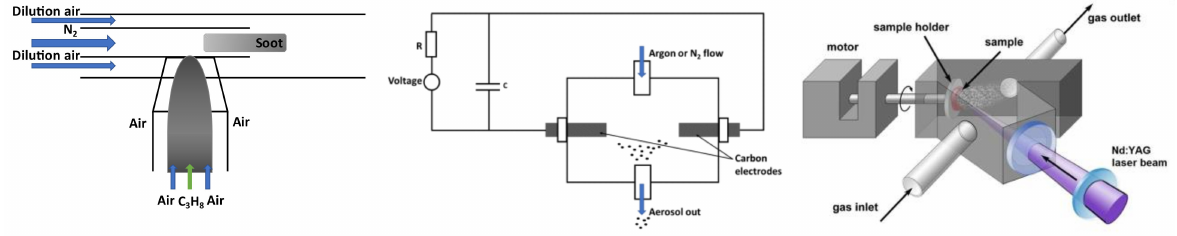
Figure 3. The schematic of the experimental set-up of soot generator using different excitations: sooting flame ( left ), spark discharge ( center ), laser ablation ( right